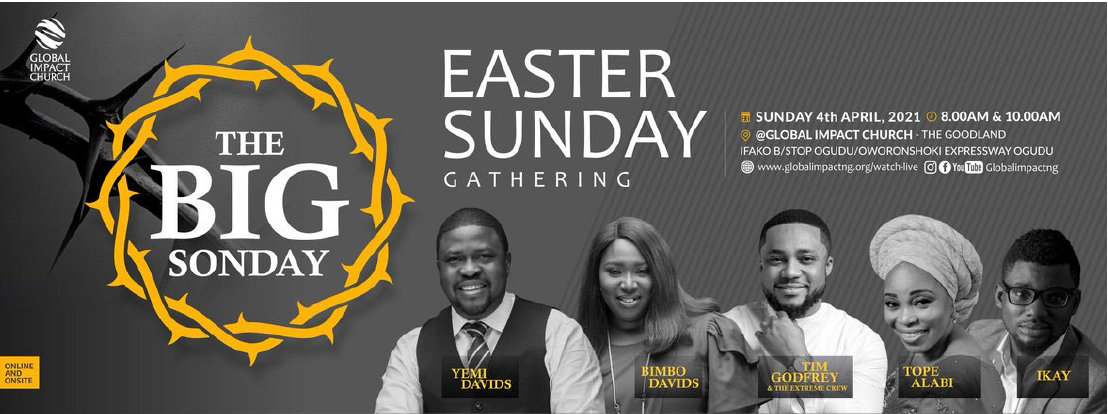
Figure 3. This is a poster promoting/inviting people to an Easter Sunday service at one of the contemporary/emerging Pentecostal churches, Global Impact Church. Alongside the pictures of the host pastor and his wife, Yemi and Bimbo Davids, are pictures of three superstar Nigerian gospel musicians: Tim Godfrey, Tope Alabi, and Ikay. (Image: courtesy of the Global Impact Church, Ogudu, Lagos, accessed on 15 January